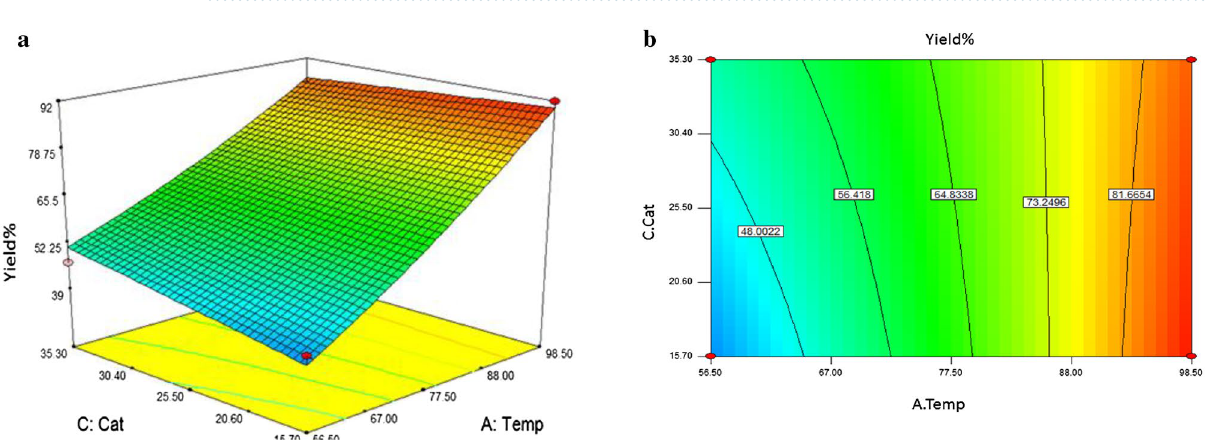
Figure 9. Three-dimensional response surface ( a ) and contour plot for reaction temperature (A) versus molar ratio of acid: alcohol (D) ( b ).